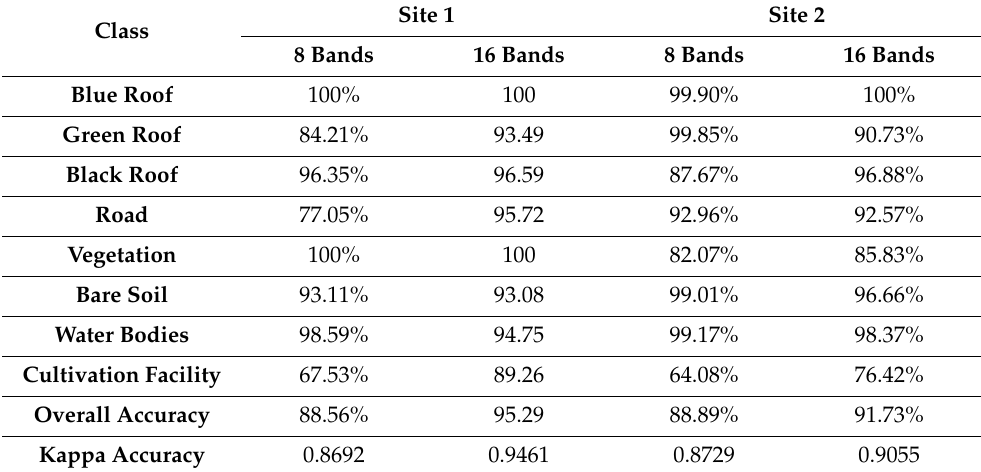
Table 4. Results of the quantitative accuracy